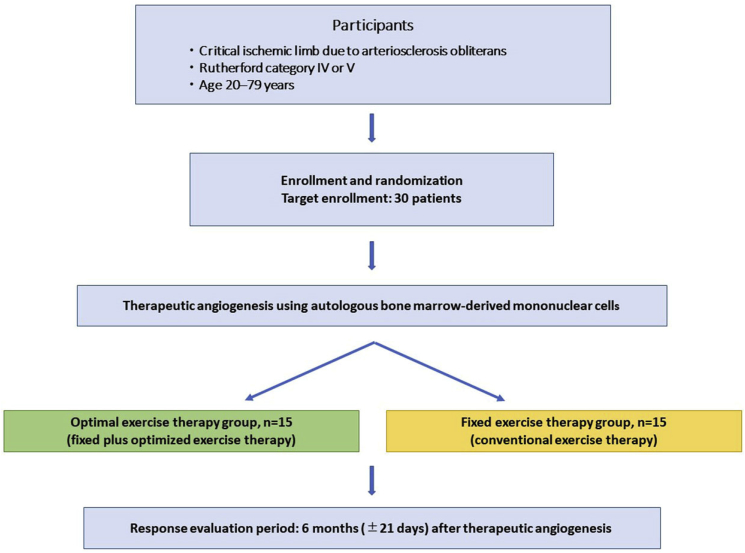
Study flow chart.